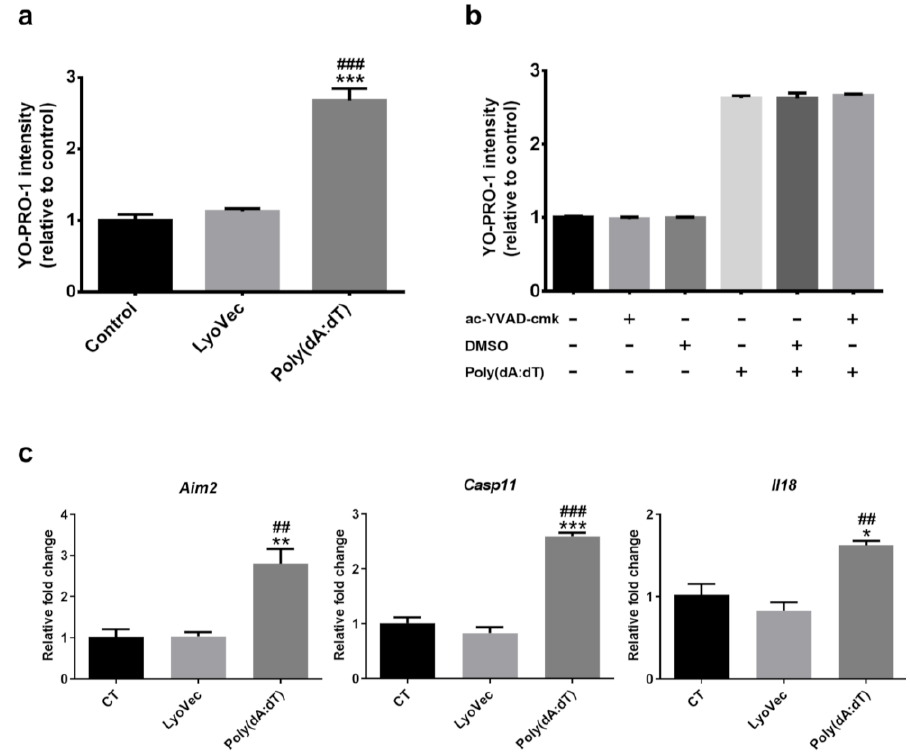
Figure 3. ( a ) 661W photoreceptor cells were incubated with Poly(dA:dT) or LyoVec (Poly(dA:dT) loading vector control), and ( b ) Poly(dA:dT) +/ − ac-YVAD-cmk (100 µ M) (Casp1 inhibitor) or DMSO (0.01%) for 8 h. The cell viability of 661W photoreceptor cells was determined by YO-PRO-1 uptake after 8 h of treatment. ( c ) Relative mRNA expression of inflammasome components in 661W photoreceptor cells after 8 h Poly(dA:dT) treatment, compared to the reference gene Actb . n = 3 per group; n represents the average of three experimental repeats. One-way ANOVA with Tukey’s post-hoc test. * p < 0.05, ** p < 0.01, and *** p < 0.001: comparison to the control. ## p < 0.01 and ### p < 0.001: comparison to LyoVec. Error bars shown as mean ±